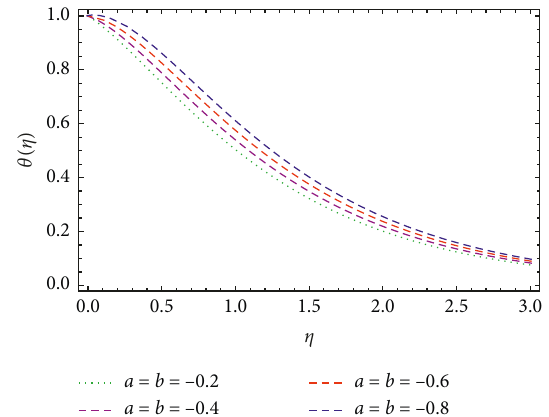
Figure 10: The influence of the velocity profile for different values of f w , when K � 0 . 1 , β � 0 . 4 , Pr � 5 . 0 ,E c � 0 . 4 , λ � 0 . 2 , and a ∗ � b ∗ � 0 . 2 .